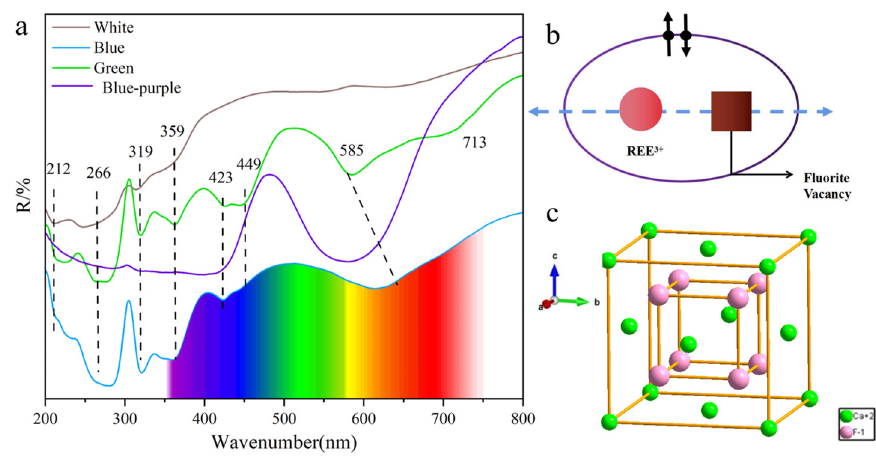
Figure 8. ( a ) UV-Vis spectra of fluorite of four colors; ( b ) REF color center model; ( c ) vacancy color center model. * b, c are adapted with permission from Ref. [15]. 1971 Staebler and Ref. [20]. 1963 O’Connor.